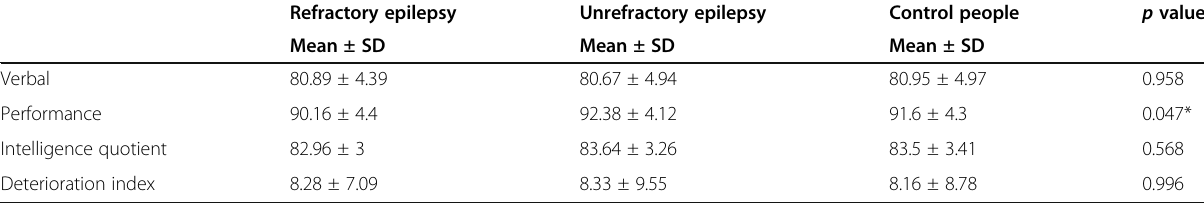
Table 3 Comparison between the studied sample group regarding intelligence quotient